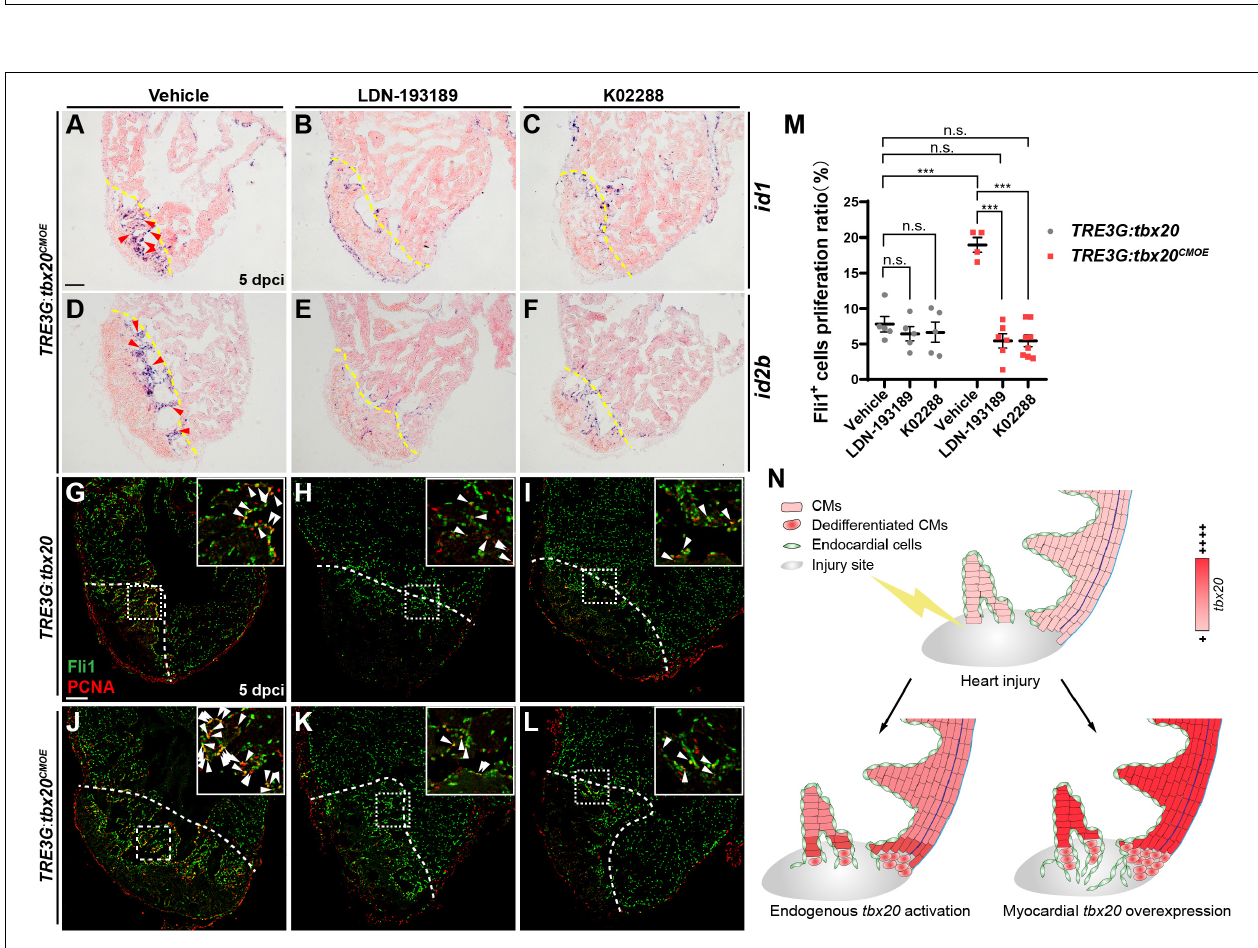
FIGURE 7 | Inhibition of Bmp6 signaling restricts endocardial cell proliferation activated by myocardial tbx20 overexpression. (A–F) Representative ISH images showing expression of id1 (A–C) and id2b (D–F) in DOX treated Tg ( TRE3G:tbx20 CMOE ) fish at 5 dpci after vehicles or inhibitors treatment. Red arrowheads indicate endocardium with id1 (A) and id2b (D) signal in the injury site. (G–L) Representative confocal fluorescence images of heart sections immunostained for Fli1 (green) and PCNA (red) from vehicle, LDN-193189 and K02288 treated control (G–I) and myocardial tbx20 overexpressing fish (J–L) at 5 dpci. Boxed areas indicate locations of the magnified insets. Arrowheads point to the Fli1 + PCNA + proliferating endocardial cells. (M) Scatter plot showing the percentage of Fli1 + cell proliferation ratio in the border zone and injury site from (G–L) . The values are mean ± S.E.M. Two-way ANOVA followed with Tukey’s multiple comparison test. n.s.: none significance, *** p < 0.001. (N) Model of myocardial tbx20 function during zebrafish heart regeneration: In CMs, myocardial tbx20 overexpression promotes CM dedifferentiation and proliferation following injury. In addition, myocardial tbx20 promotes endocardial regenerative progress by enhancing its proliferation via partially through Bmp6 signaling. Dashed lines delineate the injured area. Scale bar: 100 µ